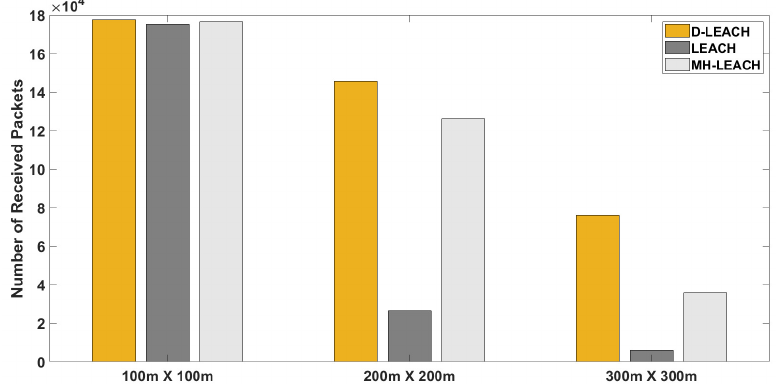
Figure 21. The number of packets received by base station (BS) while the network is